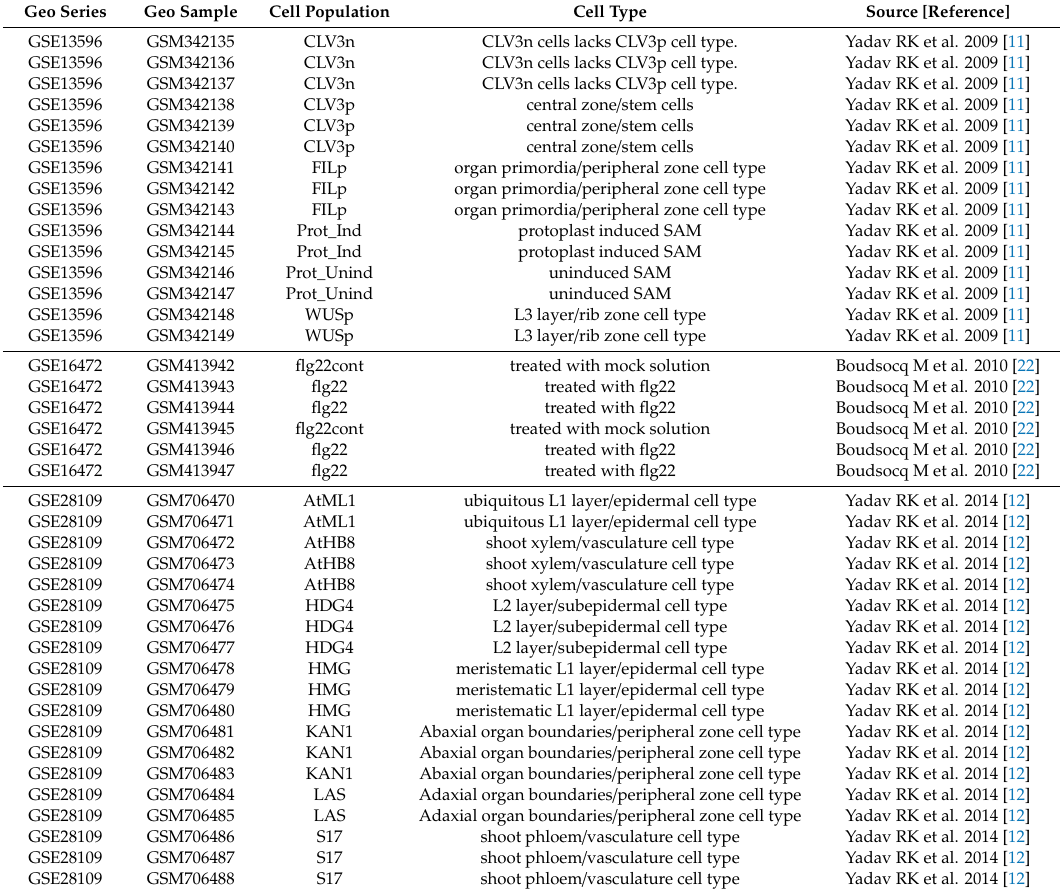
Table 1. GEO (Gene Expression Omnibus) identifiers of the transcriptomes belonging to the various shoot apical meristem (SAM) cell populations, protoplasting e ff ects, and the source of flg22-treated mesophyll cell